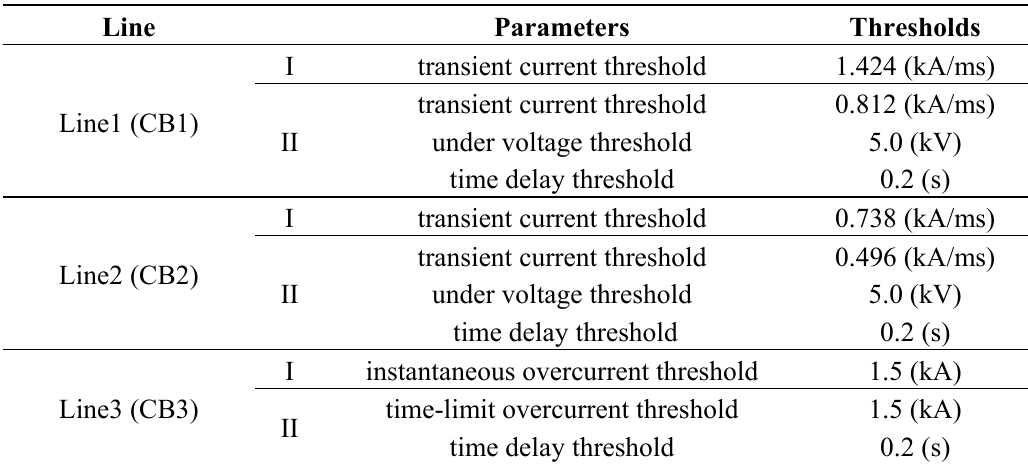
Table 1. The thresholds of